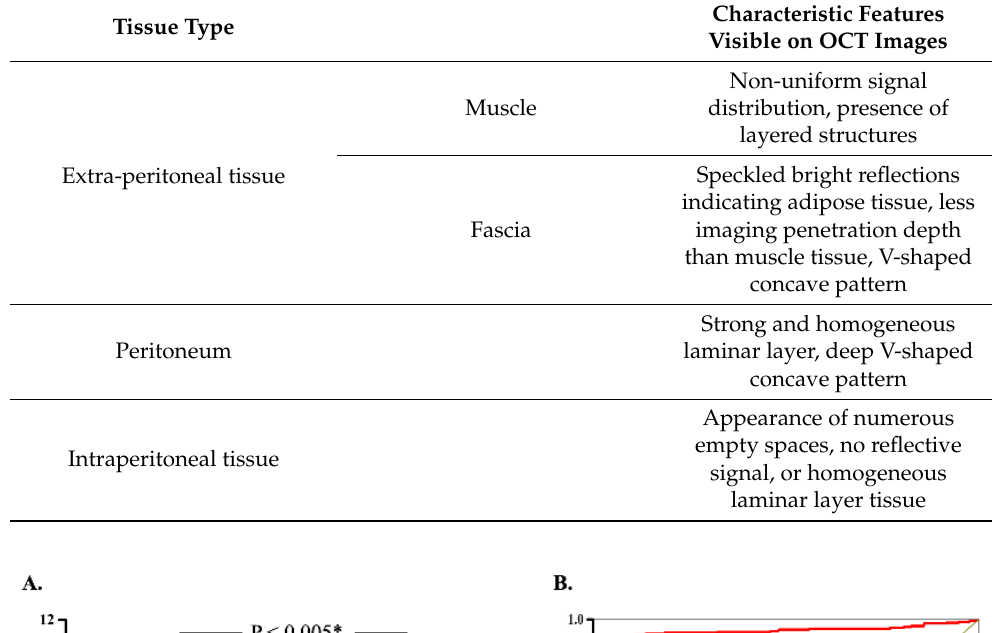
Figure 5. Veress needle probe punctured the paramedian region of the belly. ( A – D ) Around half of